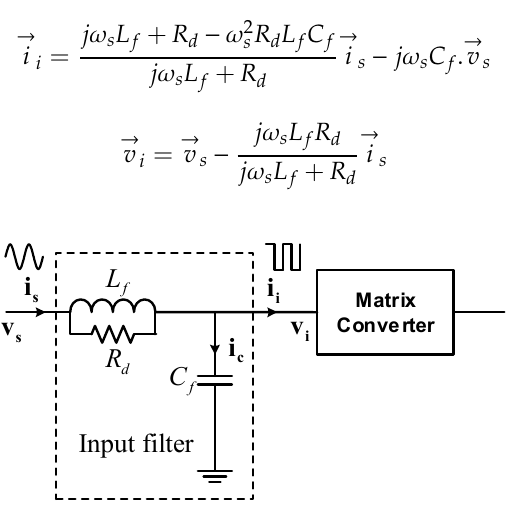
Figure 4. Equivalent circuit of input filter.